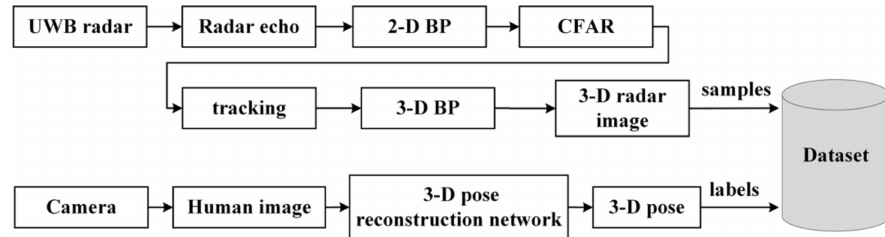
Figure 5. Flowchart of the dataset